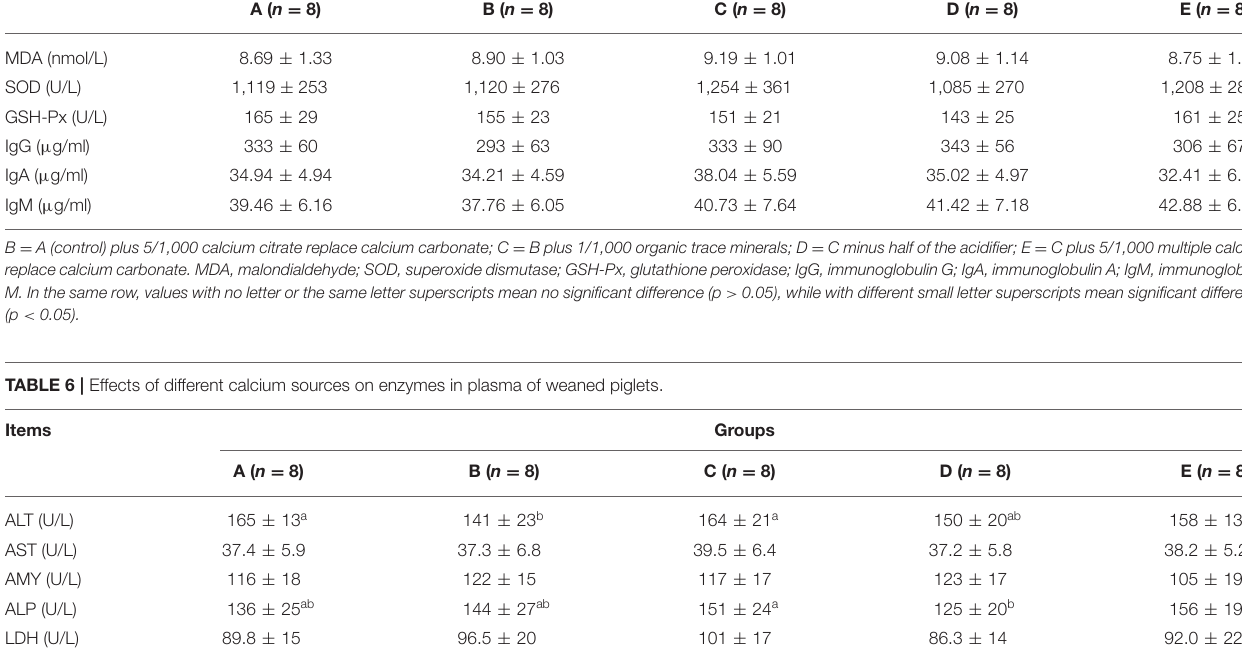
TABLE 5 | Effects of different calcium sources on plasma antioxidant and immune indexes of weaned piglets. Items Groups